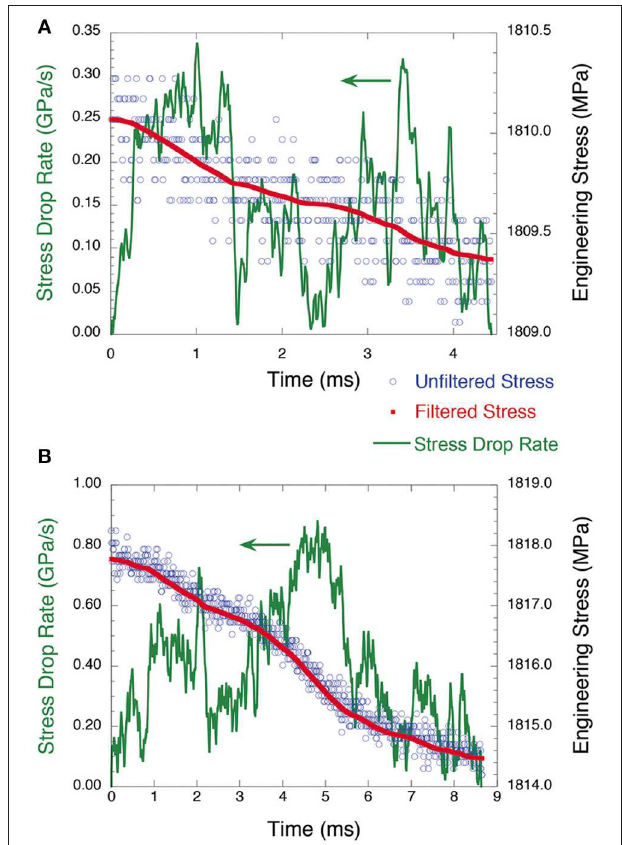
FIGURE 4 | The stress drop rate ˙ S vs. time for a single avalanche in the small avalanche regime after Wiener filtering is performed. The unfiltered and Wiener-filtered data for stress vs. time are also shown. The axes scales are different for the plots. (A) This avalanche lasts ∼ 4.4ms with a stress drop size of 0.7 MPa and a maximum stress drop rate of 0.34 GPa/s. (B) This avalanche lasts ∼ 8.6ms with a stress drop size of 3.3 MPa and a maximum stress drop rate of 0.88 GPa/s [Reprinted from Wright et al. [ 27], with the permission of AIP Publishing].